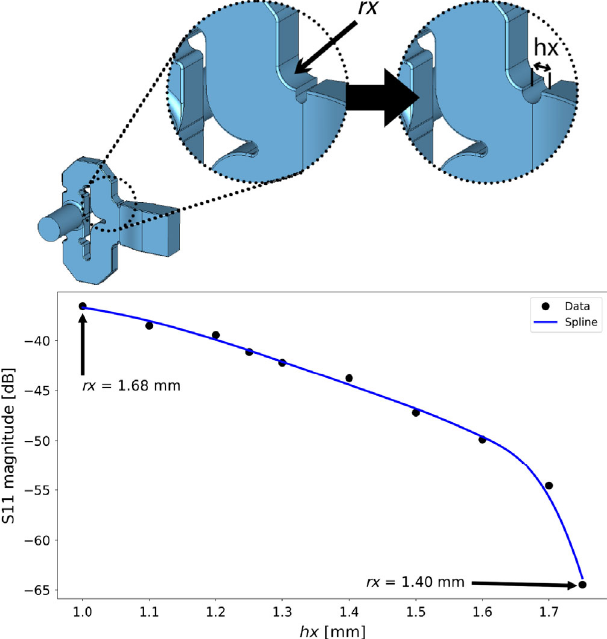
FIG. 17. Geometrical parameters rx and hx (top). The magni- tude of the mode converter ’ s minimum reflection, tuned to 36 GHz, as a function of hx